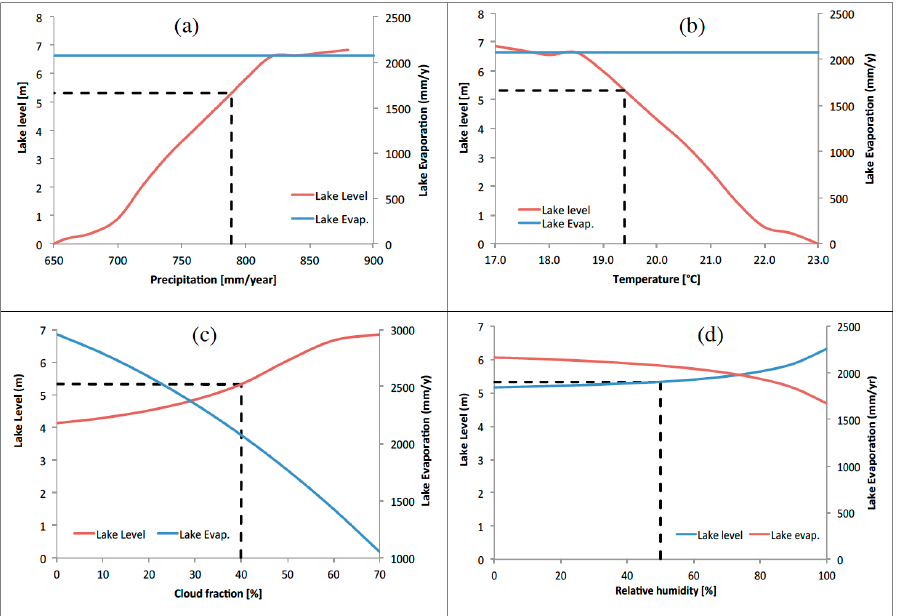
Figure 8. Lake water level sensitivity to changes in ( a ) Precipitation; ( b ) Temperature; ( c ) Cloud Fraction and ( d ) Relative Humidity. The horizontal dashed line represents the current lake level and the vertical dashed line corresponds to the current value of the respective parameter.